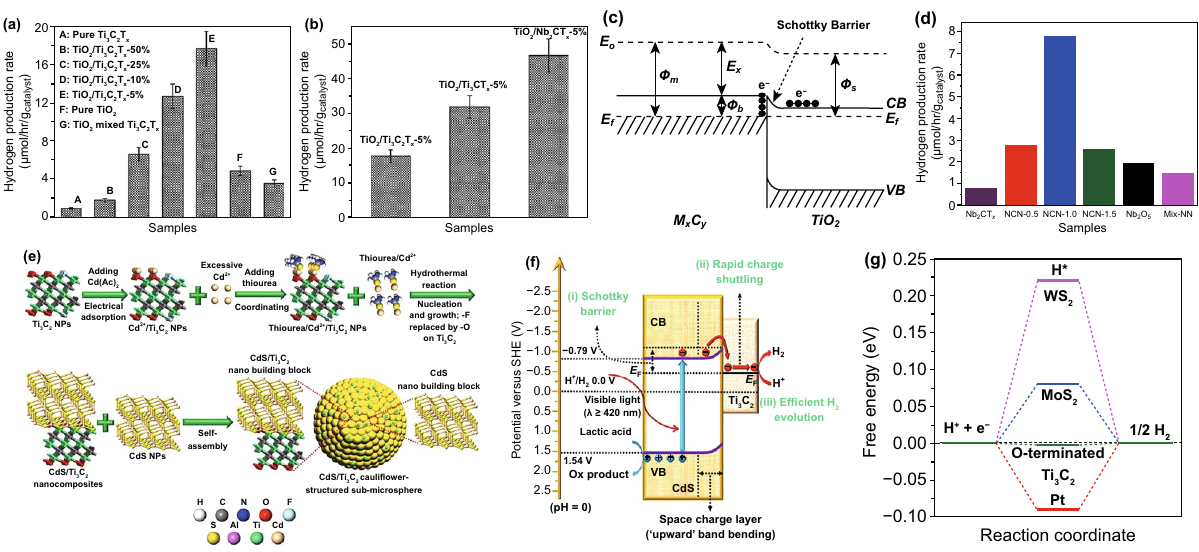
Fig. 19 a – c Photo‑catalytic H 2 formation rates of TiO 2 /Ti 3 C 2 T x and controlled samples. ( a ) Photo‑catalytic HER activity of TiO 2 loaded with particular metal carbide MXene co‑catalysts (Ti 3 C 2 T x , Ti 2 CT x , and Nb 2 CT x ), ( b ) formation of SB at MXene/TiO 2 hetero‑interface, and ( c ) Wang et al. [240]. d Photo‑catalytic HER of Nb 2 O 5 /C/Nb 2 C samples (Tongming Su et al. [242]). e–g Fabrication method of CdS/Ti 3 C 2